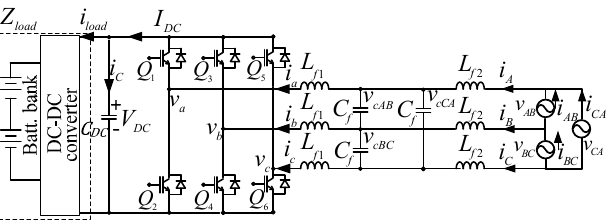
Figure 1. PWM rectifier with delta-LCL filter within the battery energy storage system (BESS) module.